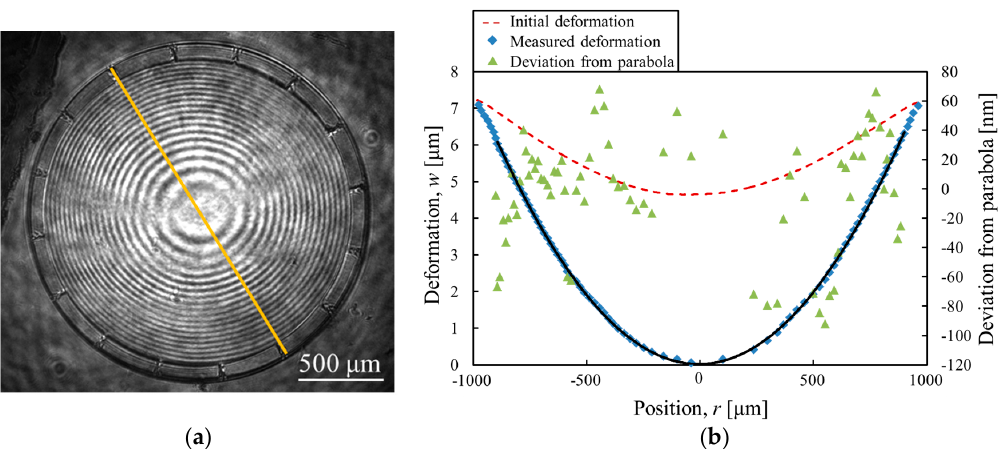
Figure 8. ( a ) Interference image and ( b ) surface profile of the varifocal mirror.